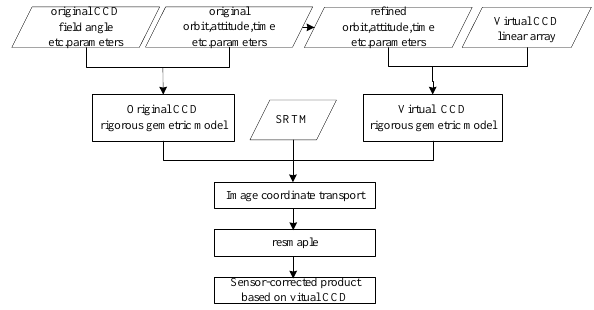
Figure 1. Flowchart of field-stitching algorithm based on the virtual CCD